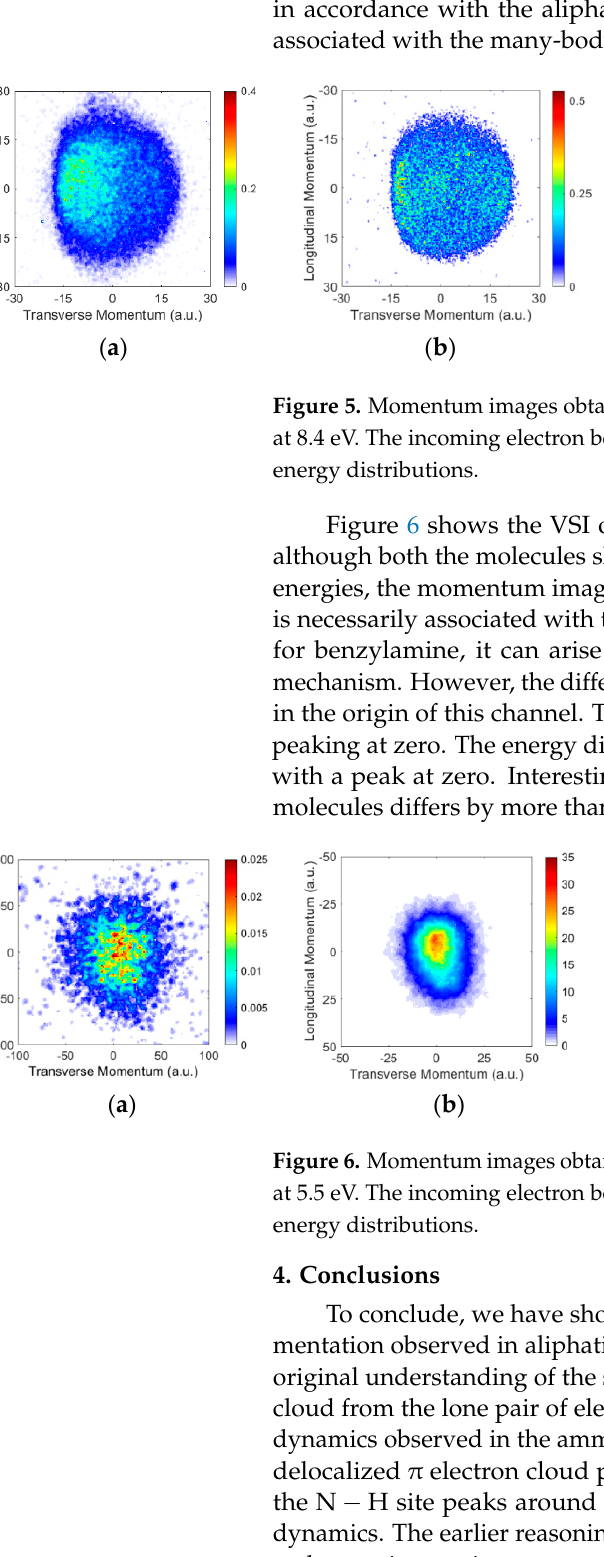
Figure 6. Momentum images obtained for the CN (cid:2879) ions from ( a ) aniline at 9.6 eV and ( b ) benzyla- mine at 5.5 eV. The incoming electron beam direction is from top to bottom; ( c , d ) are the respective kinetic energy distributions.